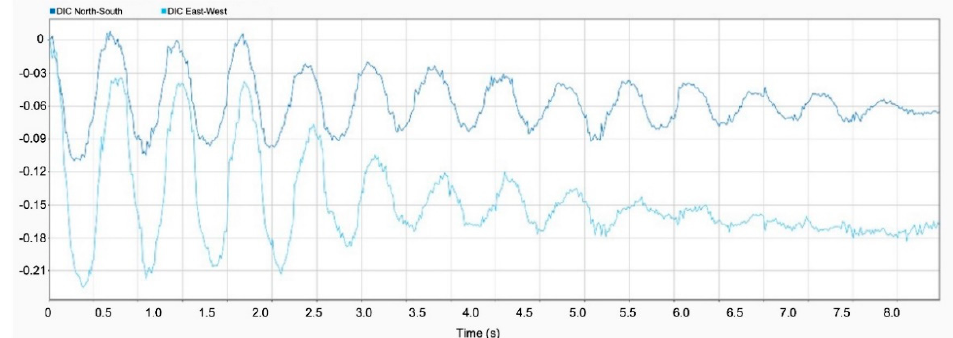
Figure 15. Signals comparison: DIC east-west direction (light blue); DIC north-south direction (dark blue); time (x-axis); amplitude expressed in pixels (y-axis).